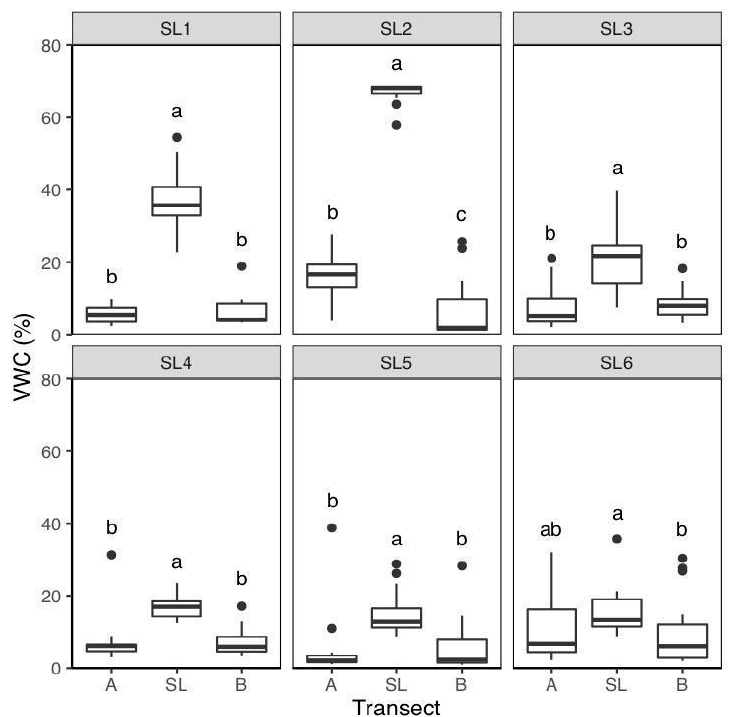
Figure 3. Near-surface (0–0.06 m) volumetric water content at each transect. Transects ‘A’ and ‘B’ are located in the adjacent peatland to the ‘SL’ transect. Letters indicate significant (p < 0.01) differences in volumetric water content between transects at each site, with no comparison amongst sites.